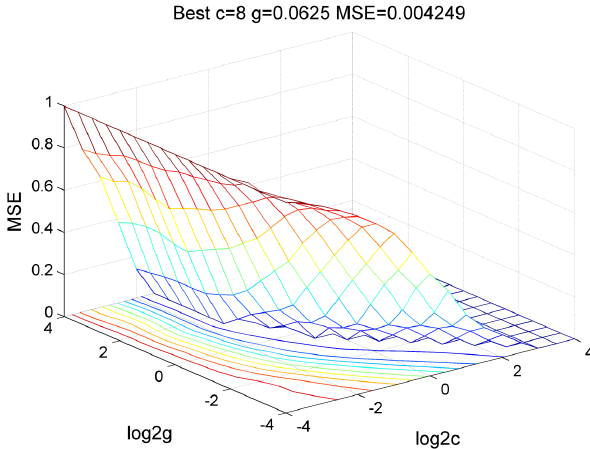
Fig. 11. The 3-D contour map of the parameter selection of the multi-factor SVM model by using grid-search